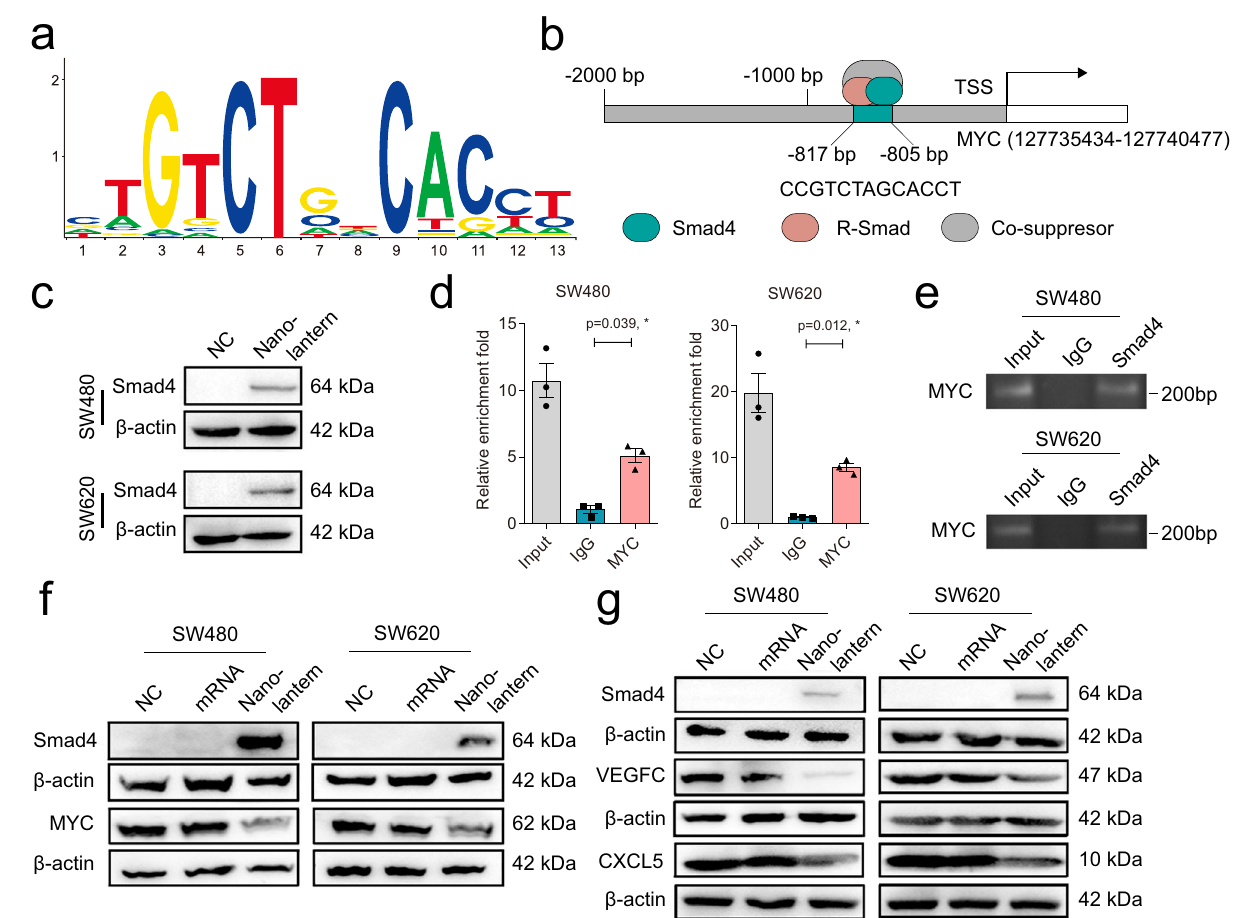
Fig. 7 | Smad4 transcriptional suppressed the expression of MYC in CRC cells. a TheSmad4potentialbindingsiteinJASPARsoftware. b Potentialrecognitionsites ofSmad4intheMYCpromoterregion. c WesternblotanalysisofSmad4expression in SW480 and SW620 cells before and after treatment with nano-lantern. d ChIP assays with anti-Smad4 or negative control (anti-IgG) antibodies showed Smad4 binding to the recognition site ( n =3 independent biological samples). e RepresentativeagaroseelectrophoresisforChIPanalysisofSmad4bindingtothe MYC promoter from 3 independent experiments. f Representative western blot